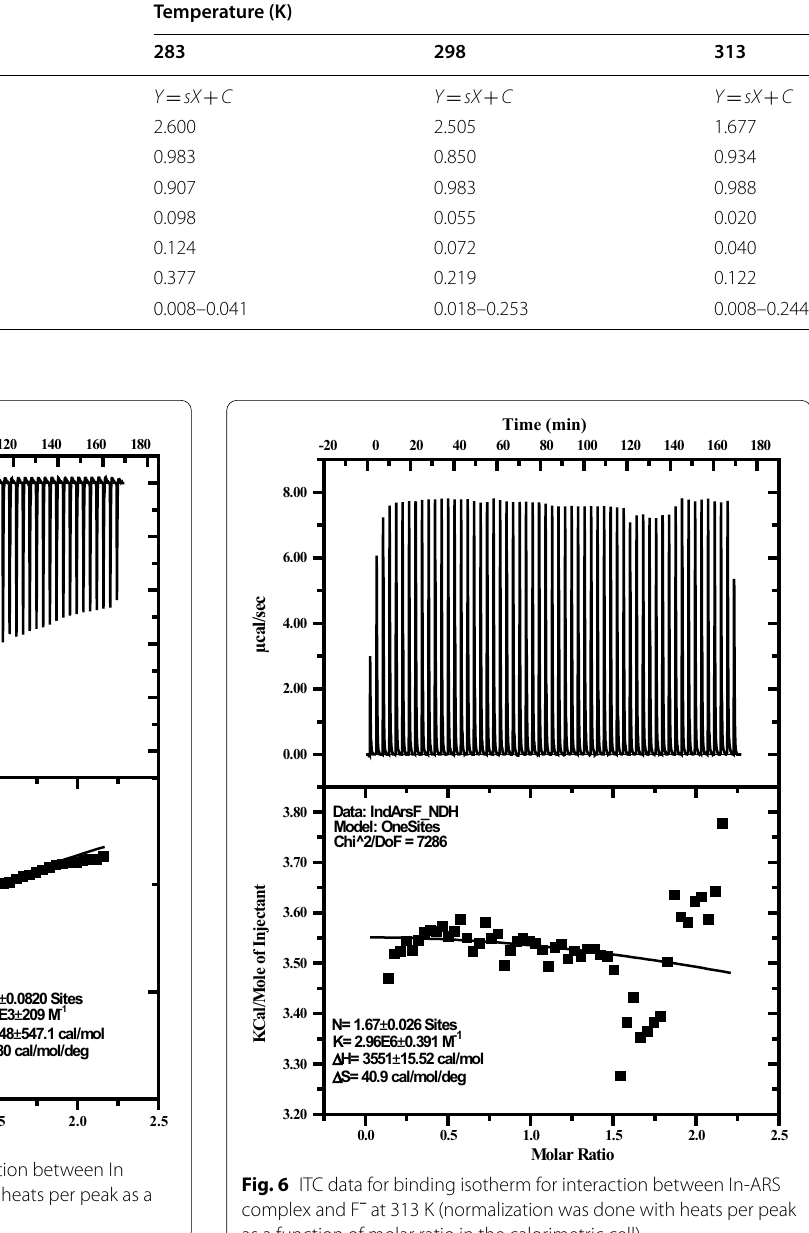
ships Eqs. 1 and 2. From Eq. (1), the ΔG value is equal to 4211.42 cal/mol and from Eq. (2), the ΔG value is equal − to 4192.14 cal/mol. −